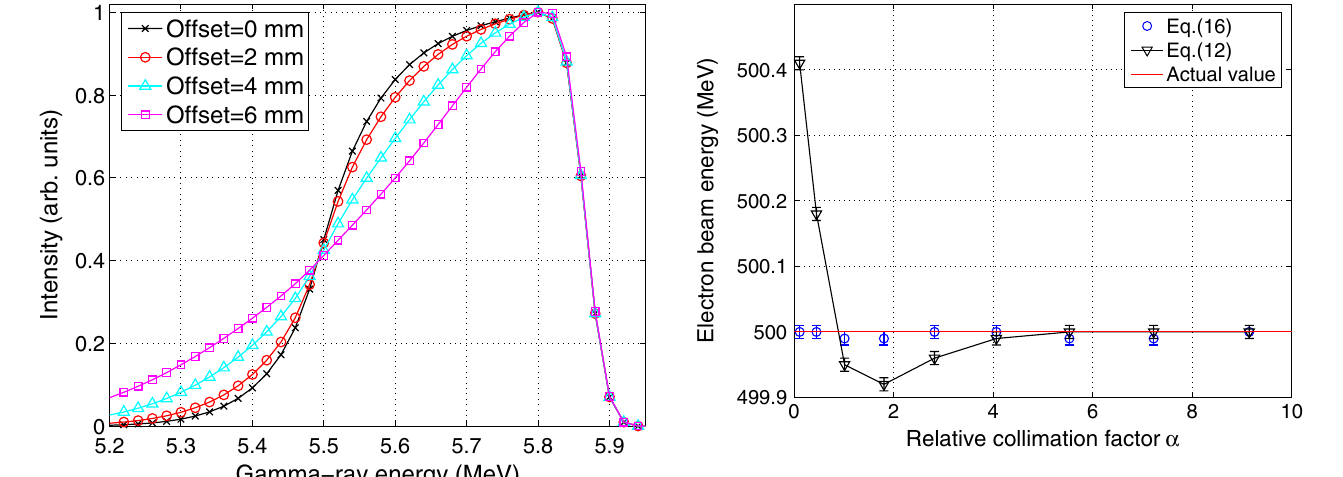
FIG. 6. (Color) The fit electron beam energy as a function of the relative collimation factor (cid:8) . Both Eq. (16) and Eq. (12) are used for the determination of the electron beam energy. The error bars represent fitting errors. The horizontal line represents the actual energy value of the electron beam used in producing simulated gamma beam spectra.